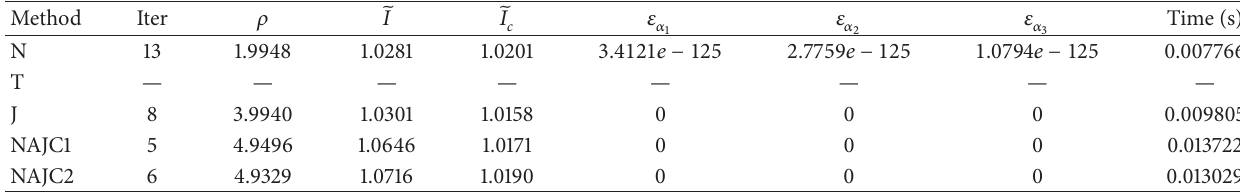
Table 6: Results of system (b), 𝑥 (0) = (12,−2, −1) 𝑇 .